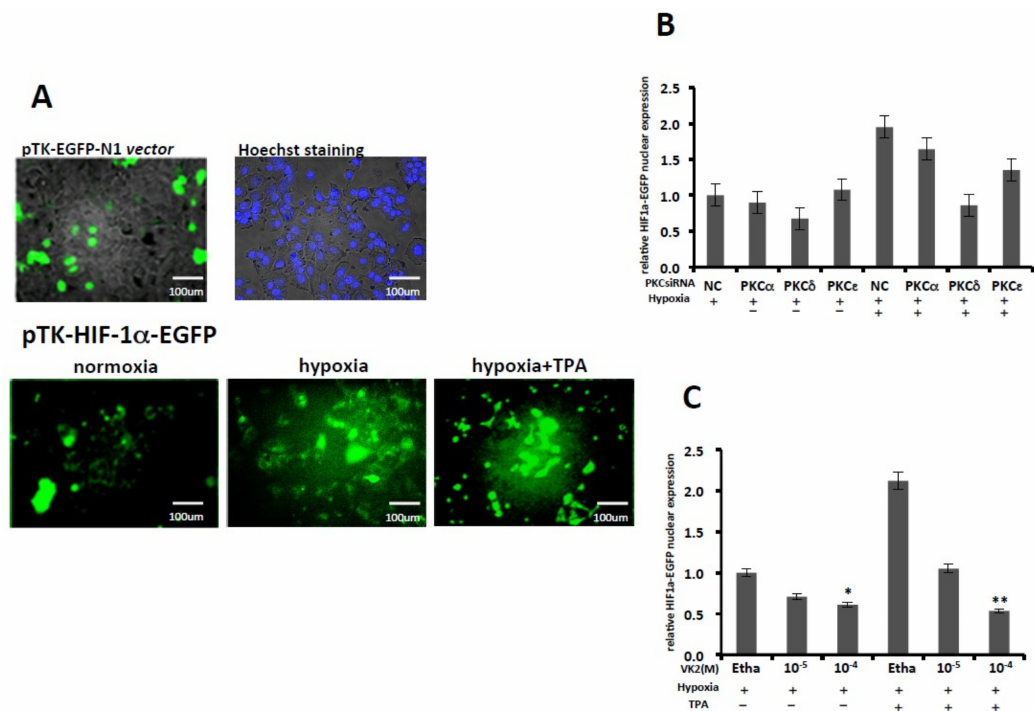
Figure 4. The role of PKC isoforms and the effects of VK2 on the nuclear translocation of HIF-1 α in Huh7 cells. After transfection with pTK-EGFP-N1 or pTK-HIF-1 α -EGFP-N1 plasmids, the cells were plated onto 3.5-cm dishes for further treatment and subjected to observation under a microscope. ( A ) Upper panel: the pTK-EGFP-N1 vector expression under normoxic conditions in Huh7 cells. Nuclear staining by Hoechst was done as the control. Lower panel: the pTK-HIF-1 α -EGFP-N1 vector expression under the indicated conditions. ( B ) The effects of PKC isoform knockdown on the translocation of HIF-1 α induced by TPA under hypoxic conditions. The HIF-1 α -EGFP expression was observed with Hoechst staining as a control under florescence microscope. The positive cells were counted and totaled in the graph. ( C ) The effects of VK2 on the translocation of HIF-1 α -EGFP to the nucleus. VK2 inhibited the nuclear expression of EGFP-positive cells. Thousands of cells were counted in each experiment. Experiments were repeated three times, and similar results were obtained. * p < 0.05; ** p < 0.01 (Student (cid:48) s t -test). Etha, Ethanol; NC, negative control